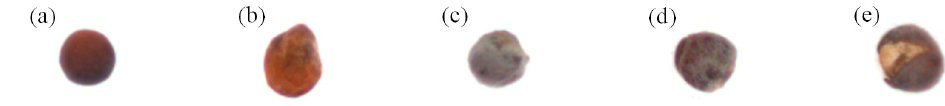
Figure 13. ( a ) Reddish-brown; ( b ) red; (c) white; ( d ) white mist; ( e ) damaged surface. Table 6. Examples of classification failure and explanations. Image Image Explanation